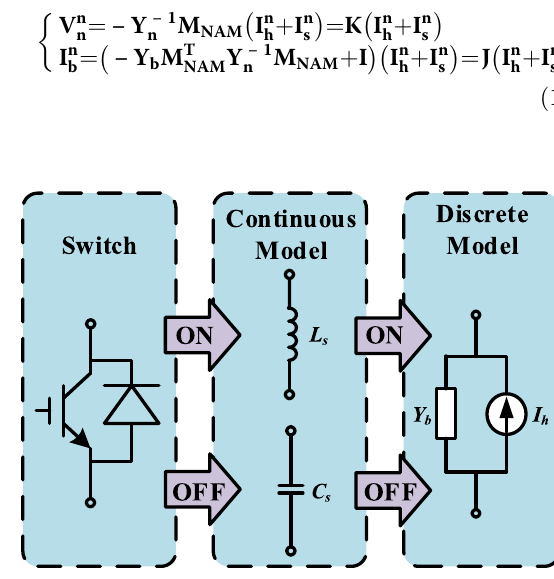
Fig. 3 Norton equivalent circuit of the